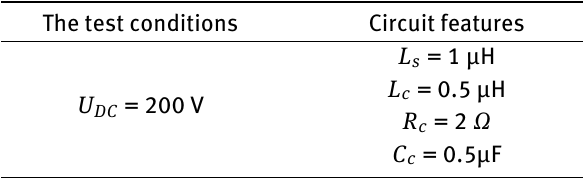
Table 1: Circuit parameter values in the case of U DC = 200